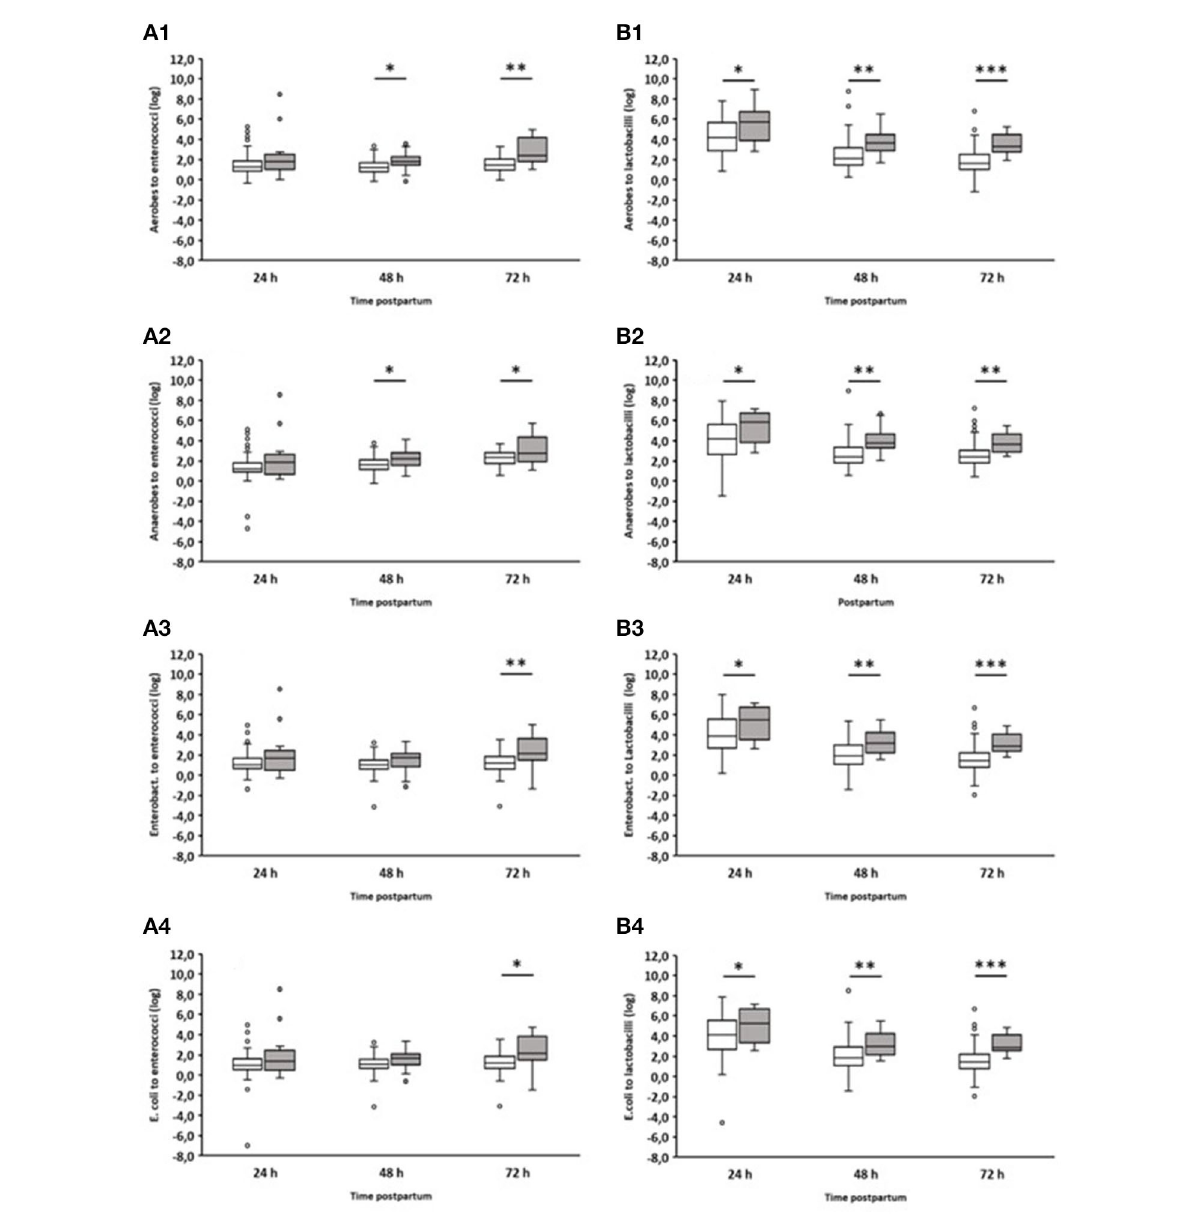
FIGURE4 Ratio of counts (cfu/g feces) of specific bacterial groups to Enterococcus spp. or Lactobacillus spp. during the first 72h after birth. (A1) Aerobic bacteria to enterococci; (A2) anaerobic bacteria to enterococci; (A3) Enterobacteriaceae to enterococci; (A4) E. coli to enterococci; (B1) Aerobic bacteria to lactobacilli; (B2) anaerobic bacteria to lactobacilli; (B3) Enterobacteriaceae to lactobacilli; (B4) E. coli to lactobacilli. White boxes: values of healthy calves ( n = 127–133); gray boxes: values of calves with diarrhea onset on day 2 ( n = 16; Wilcoxon test, * p < 0.05, ** p < 0.001, *** p <